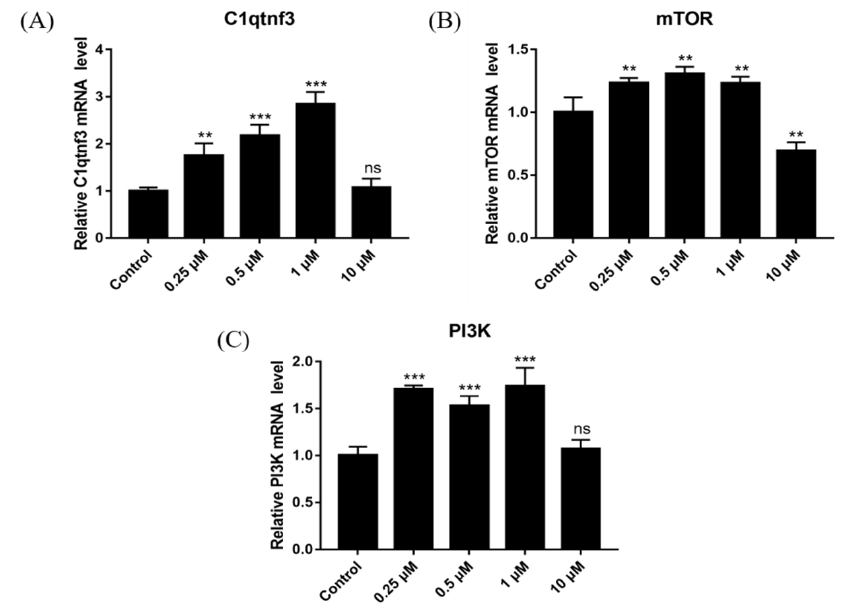
Figure 11. Effects of different concentrations of DSF on the relative mRNA expression of genes related to follicular development and maturationm. ( A ) relative expression of C1qtnf3 mRNA in different groups; ( B ) relative expression of mTOR mRNA in different groups; ( C ) relative expression of PI3K mRNA in different groups. ** p < 0.01, *** p < 0.001, ns p > 0.05.